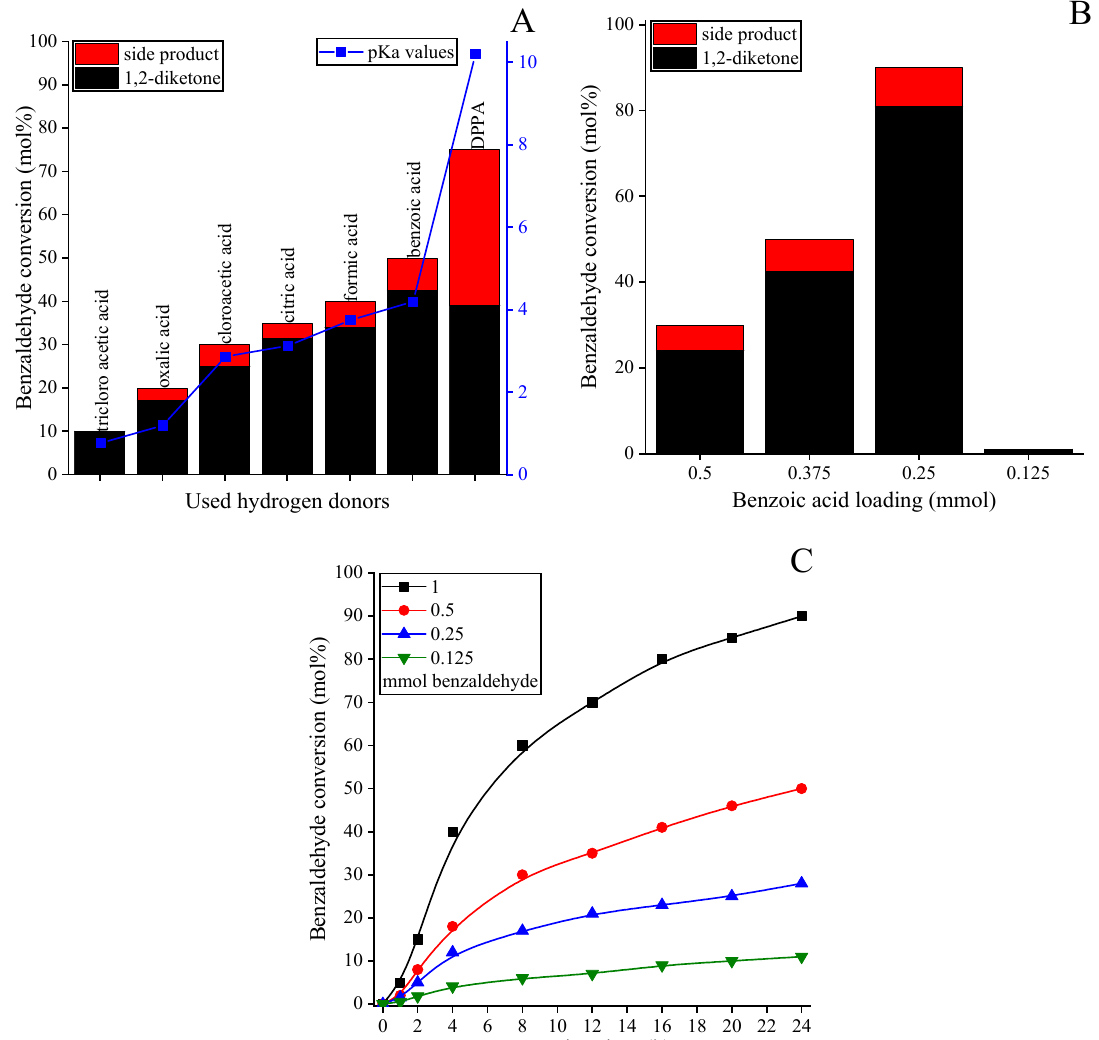
Figure 4. Benzaldehyde conversions as a function of the quality of the hydrogen donors ( A ) and benzoic acid loading ( B ). Time profiles of benzaldehyde conversions at different benzaldehyde loadings ( C ). Reaction conditions: 1 mmol benzaldehyde, 2 cm 3 acetonitrile, 0.5/0.25 mmol organic acid/benzoic acid, 5 mol% CZLPY catalyst, reflux temperature, 24 h.